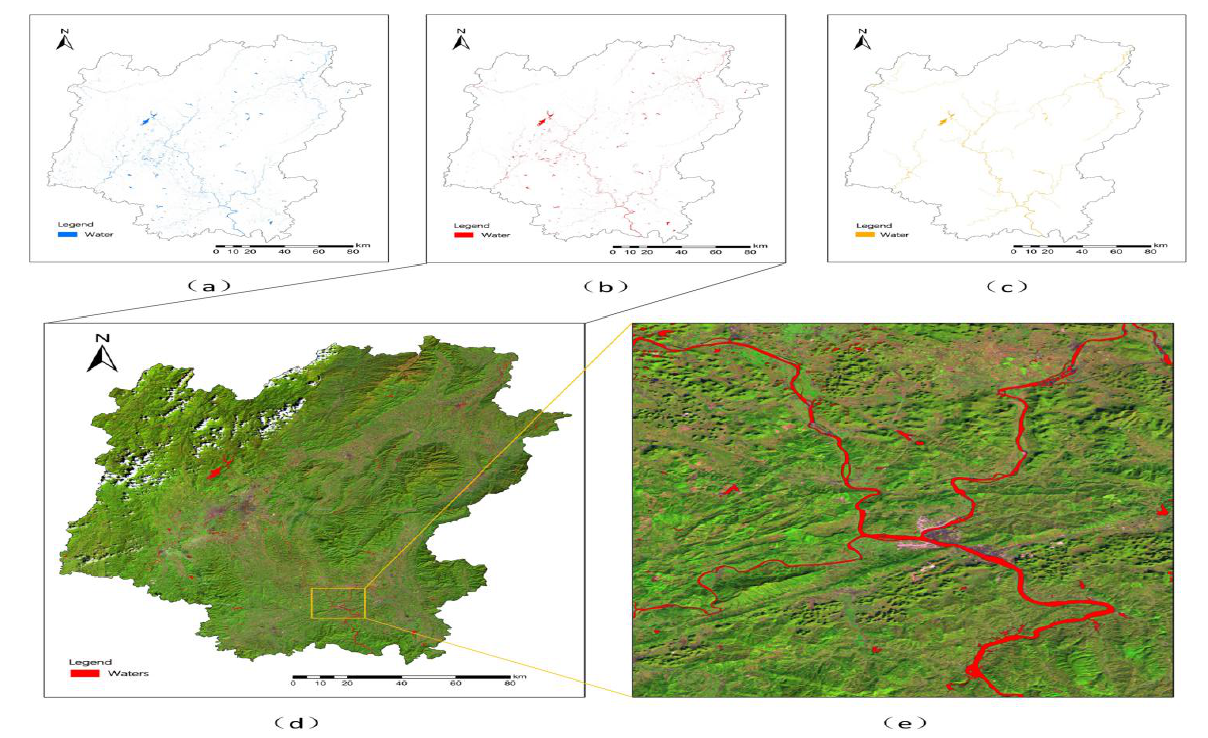
Figure 4-1 surface water distribution map of Guilin